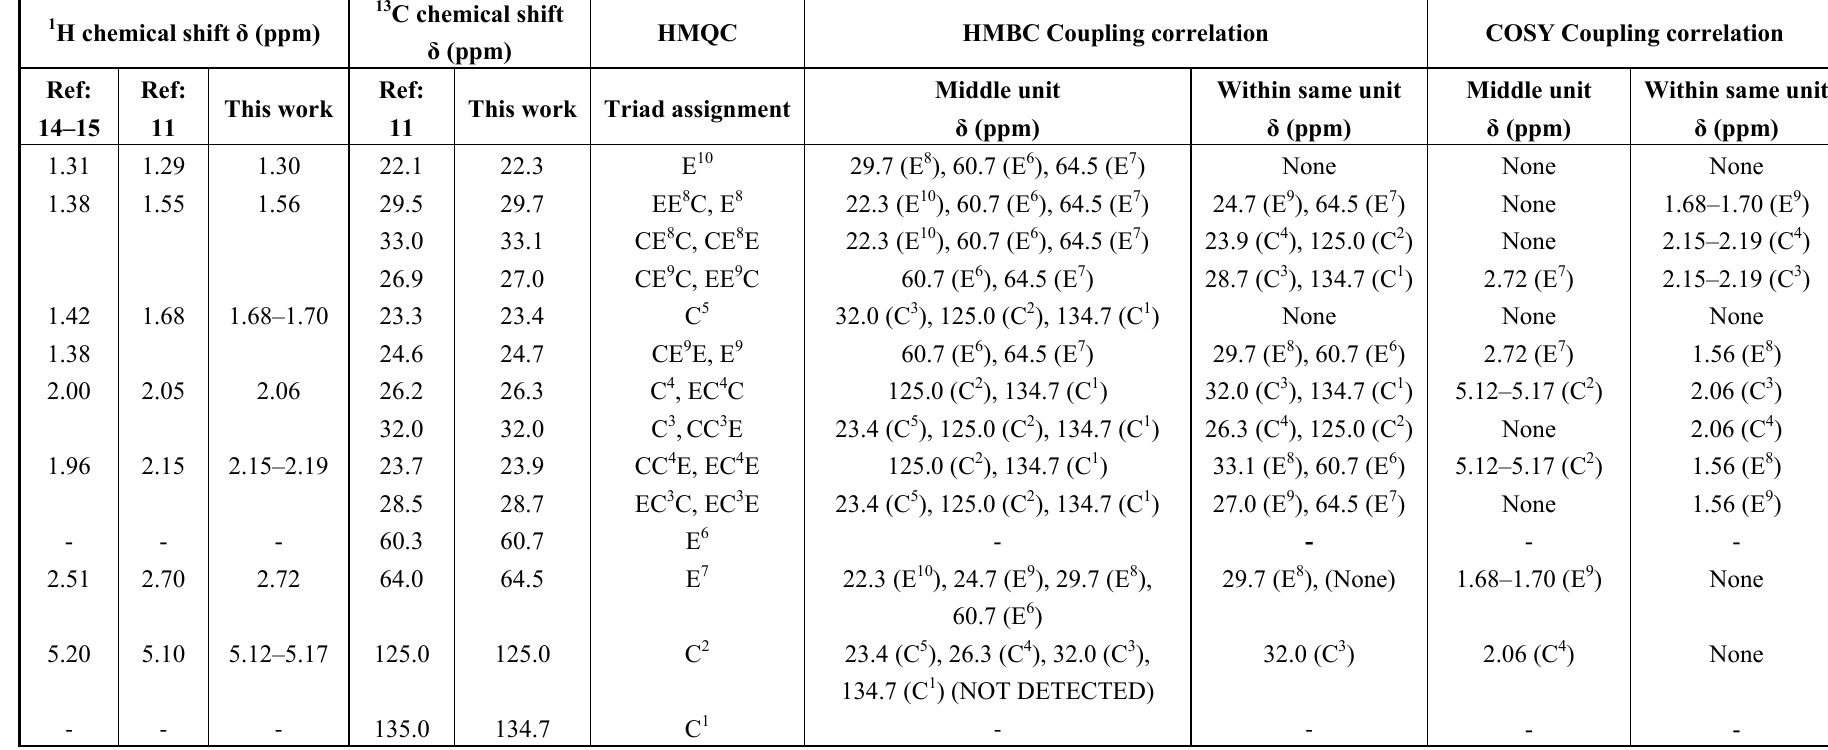
Table 1. 1 H, 13 C-NMR chemical shifts and HMQC, HMBC and COSY spin coupling correlations of purified